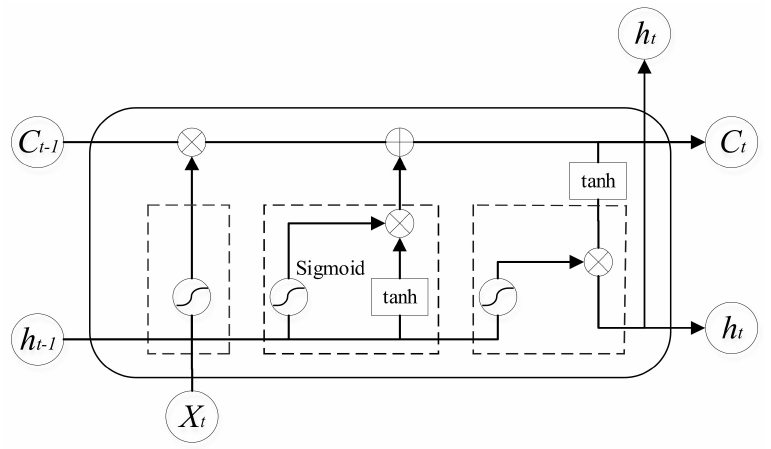
Figure 1. Structure of long short-term memory hidden